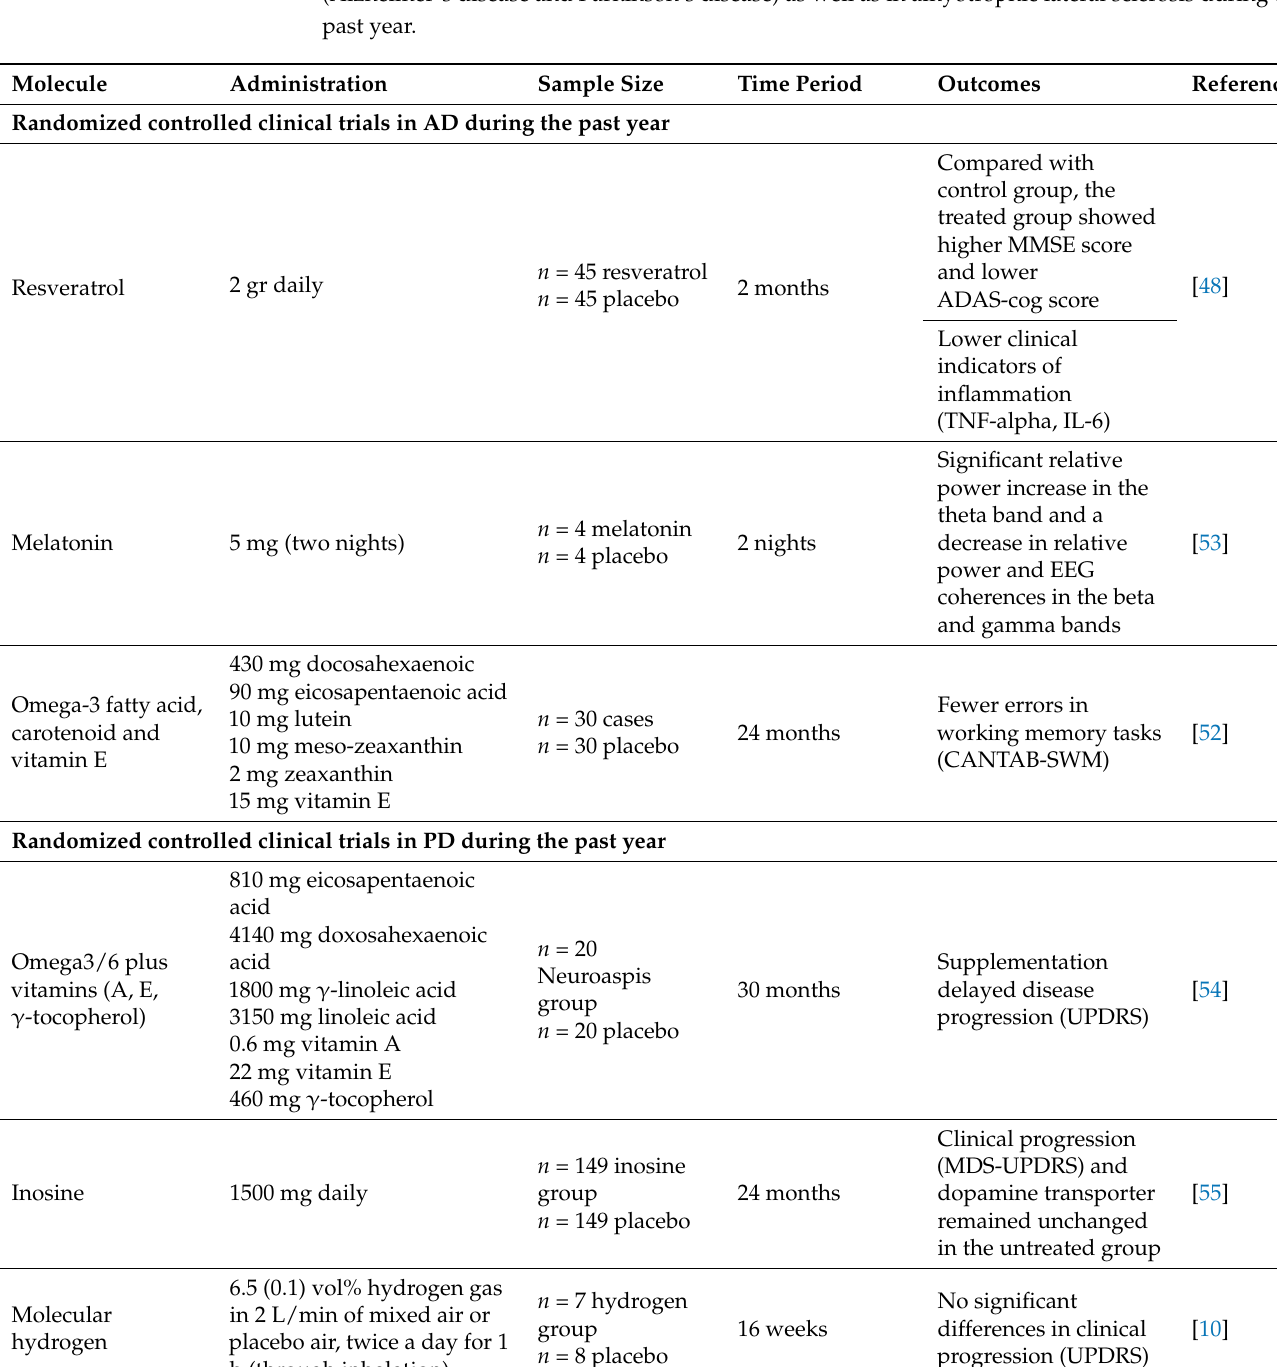
Table 2. Randomized placebo-controlled clinical trials in the main neurodegenerative disorders (Alzheimer’s disease and Parkinson’s disease) as well as in amyotrophic lateral sclerosis during the past